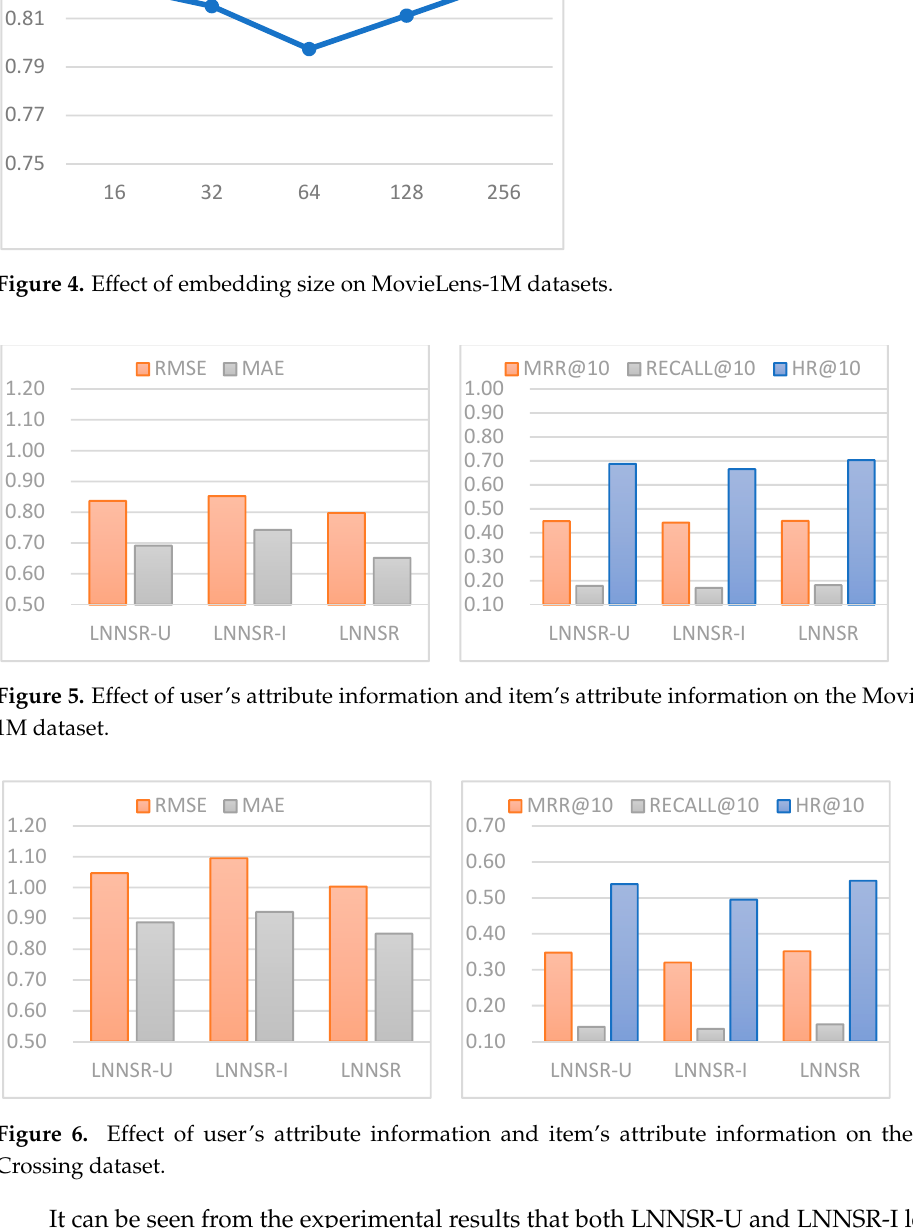
Figure 4. Effect of embedding size on MovieLens-1M datasets.